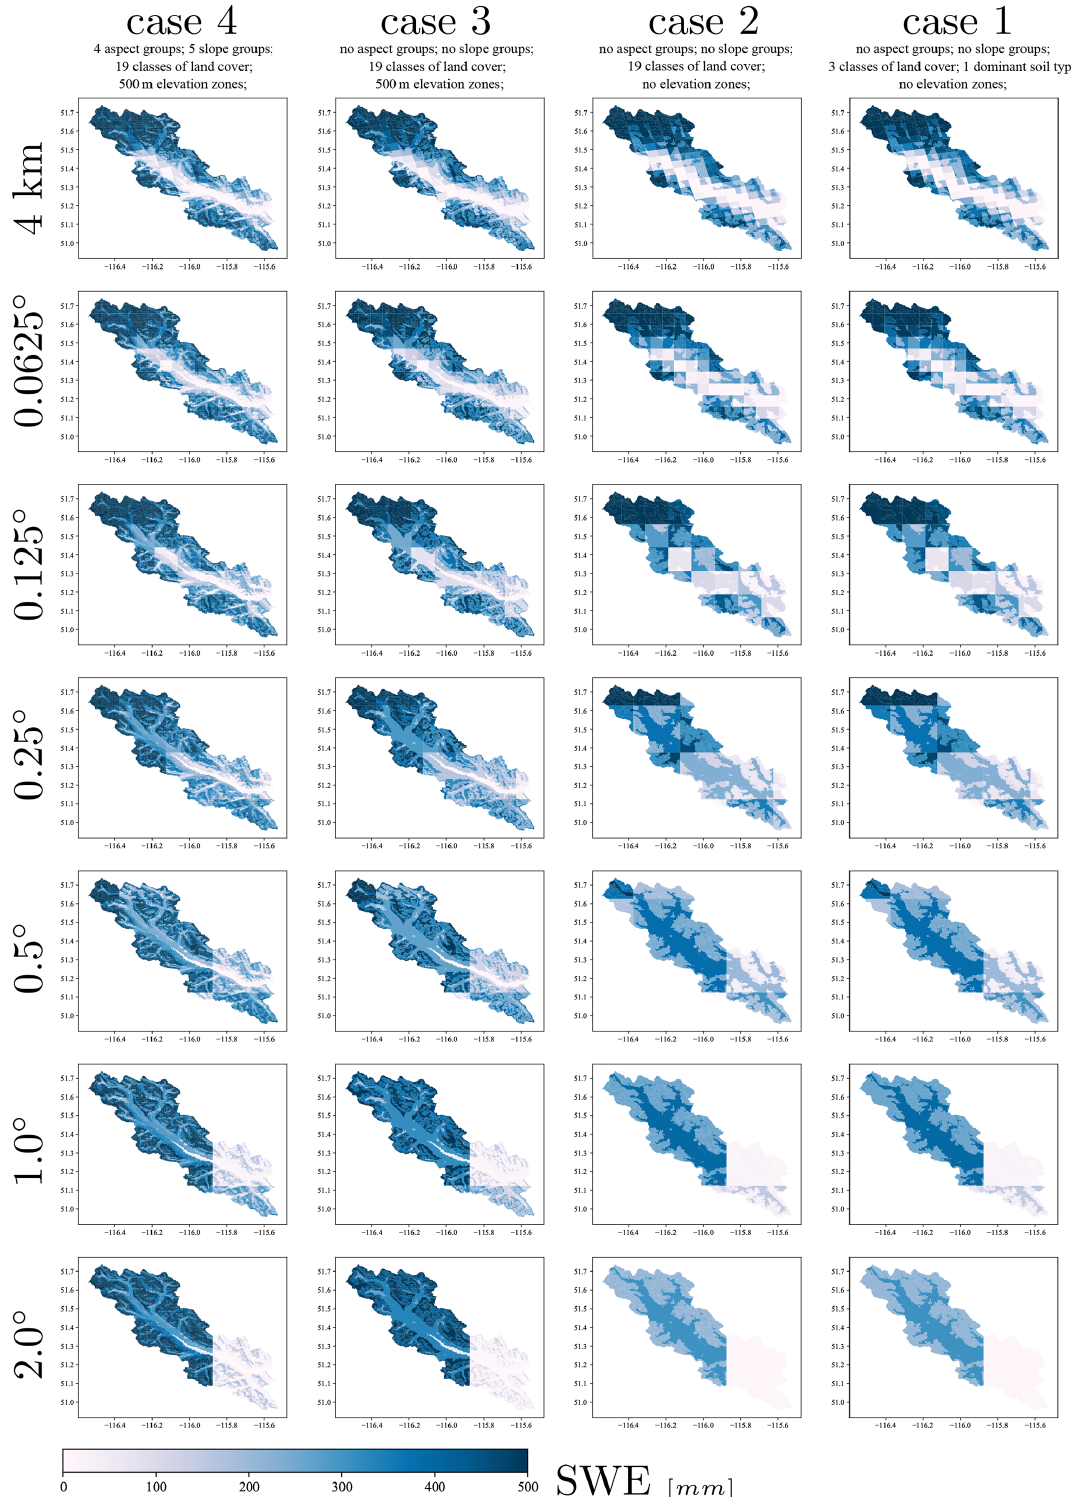
Figure 5. Comparison of the snow water equivalent for 5 May 2004 for various